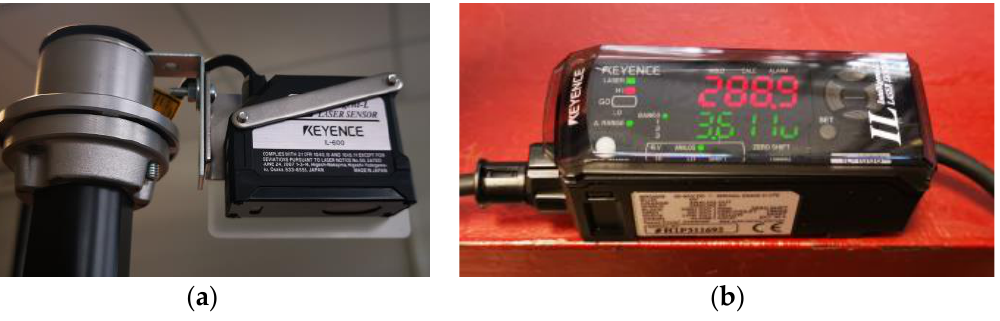
Figure 4. Laser displacement measurement system by Keyence International (Mechelen, Belgium): ( a ) sensor head type IL-600; ( b ) amplifier type IL-1000.